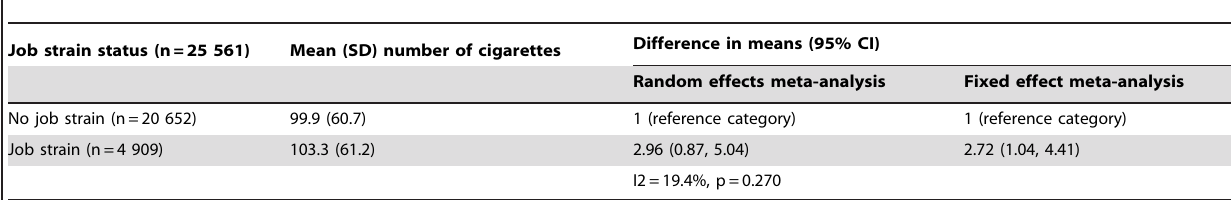
Table 2. Difference in mean number of cigarettes in an average week between current smokers with and without job strain.